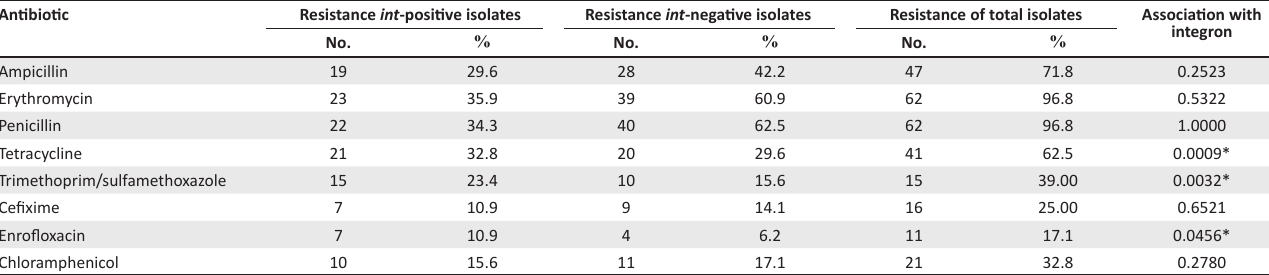
TABLE 5: Comparison of the resistances between integron-positive and integron-negative strains was done using the p -values listed in the table. Antibiotic Resistance int -positive isolates Resistance int -negative isolates Resistance of total isolates Association with integron No. % No. % No. % Ampicillin 19